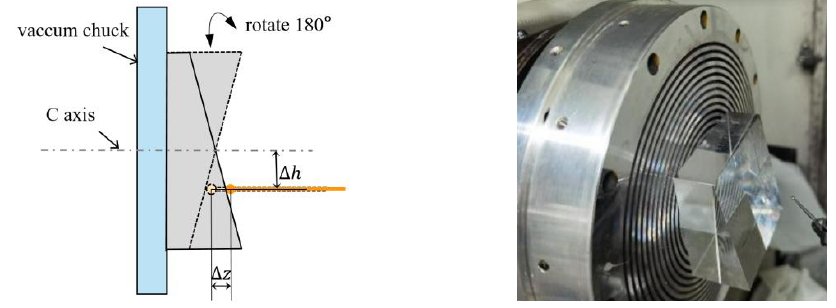
Figure 5. Height alignment of the probe with a standard wedge.